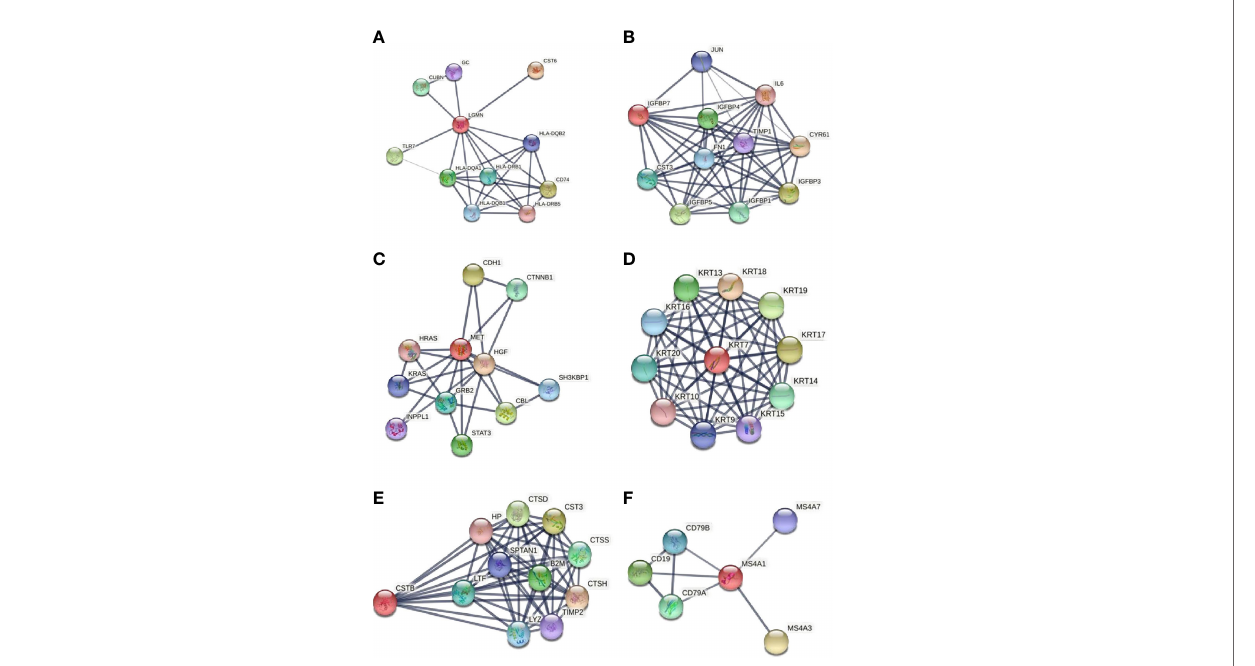
FIGURE 4 | Functional associations of the studied proteins. The colored nodes signify a direct interaction with other proteins. The con fi dence cutoff for showing interaction links has been set to “ high ” (0.700) for CD20 and ‘ highest ’ (0.900) for Legumain, IGFBP-7, HGF receptor, CK-7, and Cystatin-B. (A) Legumain ( LGMN ), (B) IGFBP-7 ( IGFBP7 ), (C) HGF receptor ( MET ), (D) CK-7 ( KRT7 ), (E) Cystatin-B ( CSTB ), (F) CD20 ( MS4A1 ). All abbreviations in fi gure 4 are explained in the Supplementary File S2